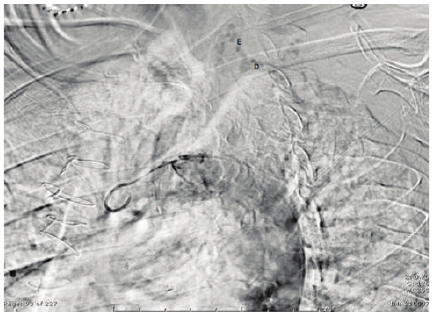
Figure 5: Perfusion of distal left SA (D) by retrograde filling from vertebral artery